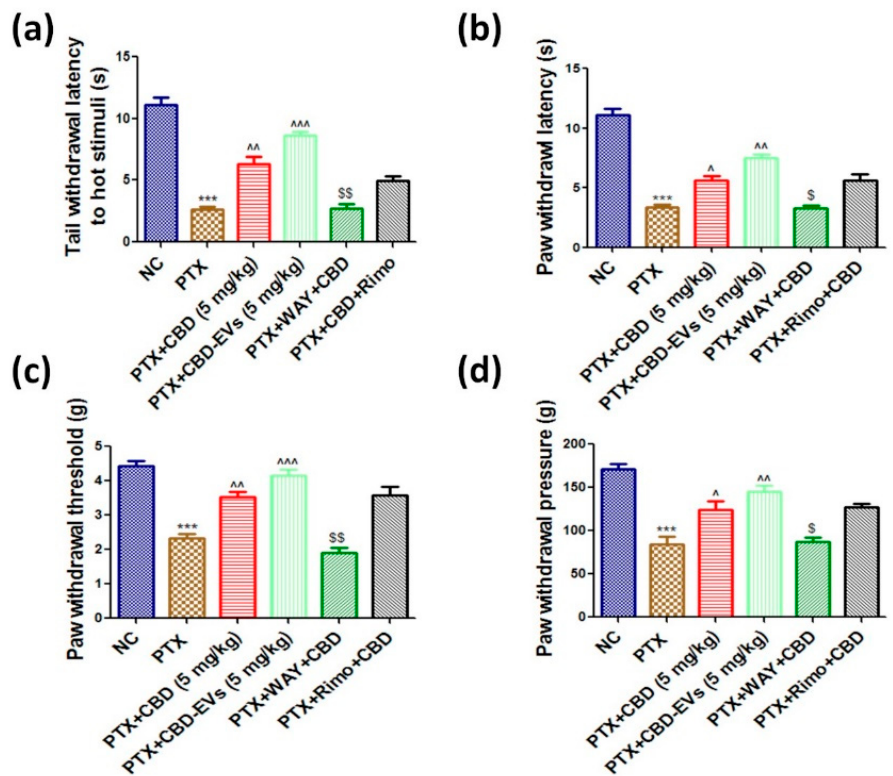
Figure 4. Effect of CBD and CBD-EVS on neurobehavior of PTX-induced neuropathic mice. Bar graphs represent ( a ) Hot immersion test ( b ) Hargreaves plantar test, ( c ) Vonfrey test, and ( d ) Randall selitto test; values are expressed as mean ± SEM (n = 3). *** p < 0.001 vs. NC, ^ p < 0.05, ^^ p < 0.01 and ^^^ p < 0.001 vs. PTX (8 mg/kg), $ p < 0.05 and $$ p < 0.01 vs. PTX + CBD (5 mg/kg). NC: untreated age-matched mice, PTX: mice received (8 mg/kg/day) on alternate days for four injections cumulatively, PTX + CBD (5 mg/kg): 5 mg/kg CBD (i.p.) injected twice a week for six weeks after the last PTX injection, PTX + CBD-EVs: 5 mg/kg of CBD loaded in hUCMSCs-derived EVs (i.p.) injected twice a week for six weeks after the last dose of PTX injection, PTX + WAY + CBD: 10 mg/kg/day, i.p., WAY100135 (5HT1A receptor inhibitor) was given to mice for four weeks and three hours before administering CBD, PTX + CBD + RIMO: 3 mg/kg/day, i.p., rimonabant (CB1 receptor blocker)